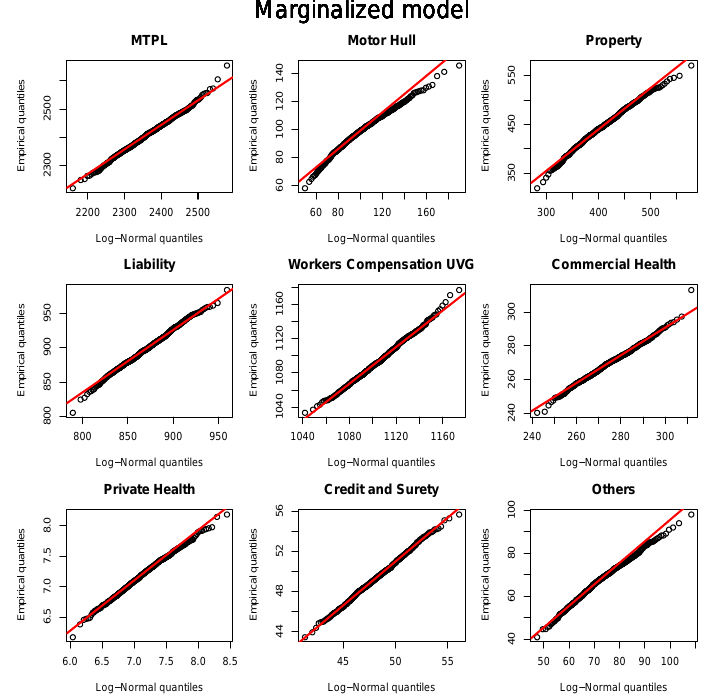
Figure 2. Quantile-Quantile plots for the different LoBs comparing (vertical axis) the empirical distribution of Z PY | F ( t ) based on Model Assumptions 1 and (horizontal axis) the log-normal approximation from Model Assumptions 3 and using posterior samples as in Figures 5 and 6. Based on 1000